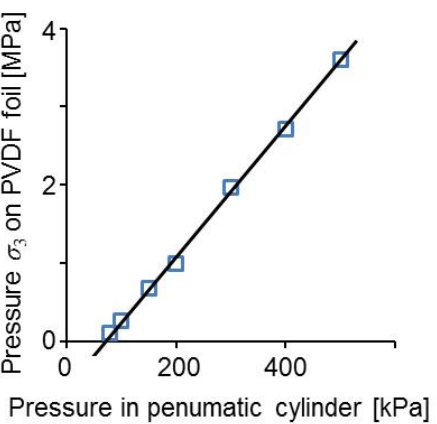
Figure 12. Pressure σ 3 on the PVDF foil as a function of the pressure in the pneumatic cylinder of the friction welding machine .